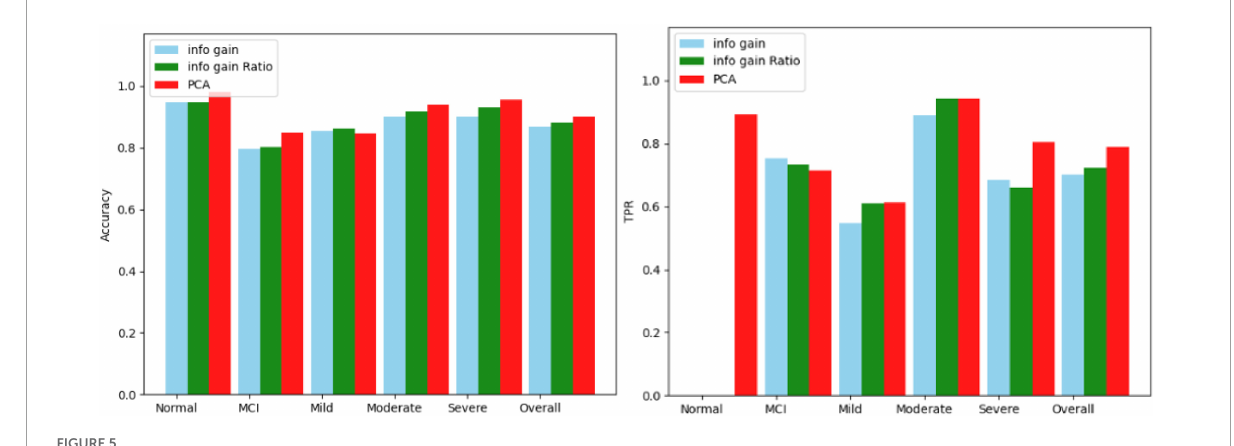
FIGURE5 Comparison results for 19 questions.